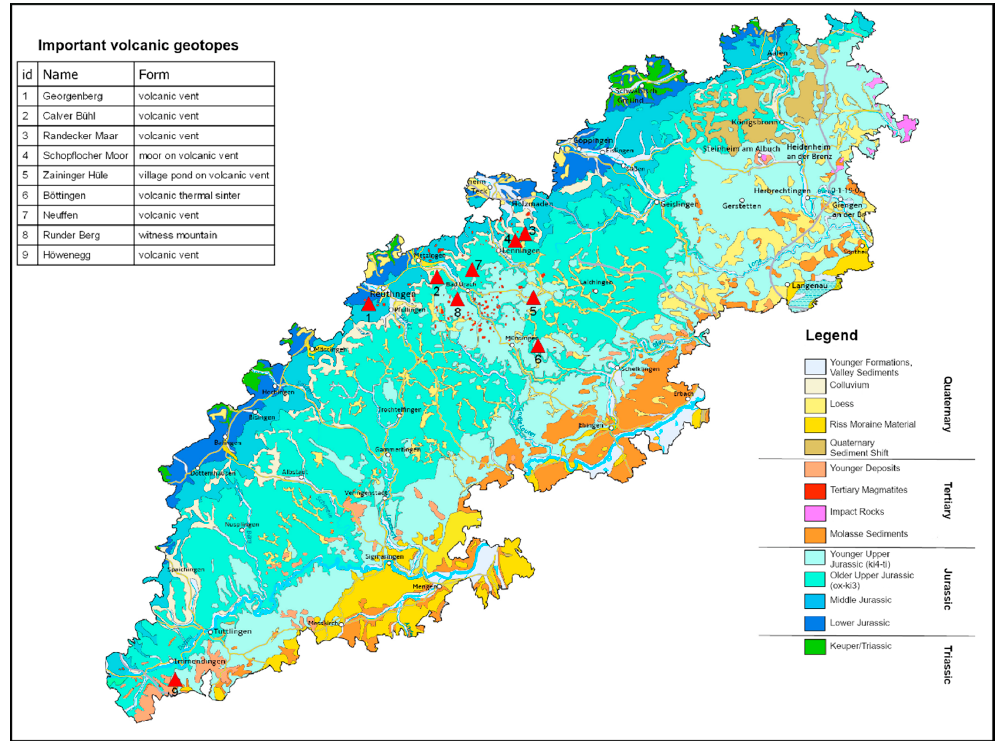
Figure 4. Geological map of Geopark Swabian Alb with outstanding volcanic geotopes (Author’s Design based on Data from Geopark Swabian Alb).